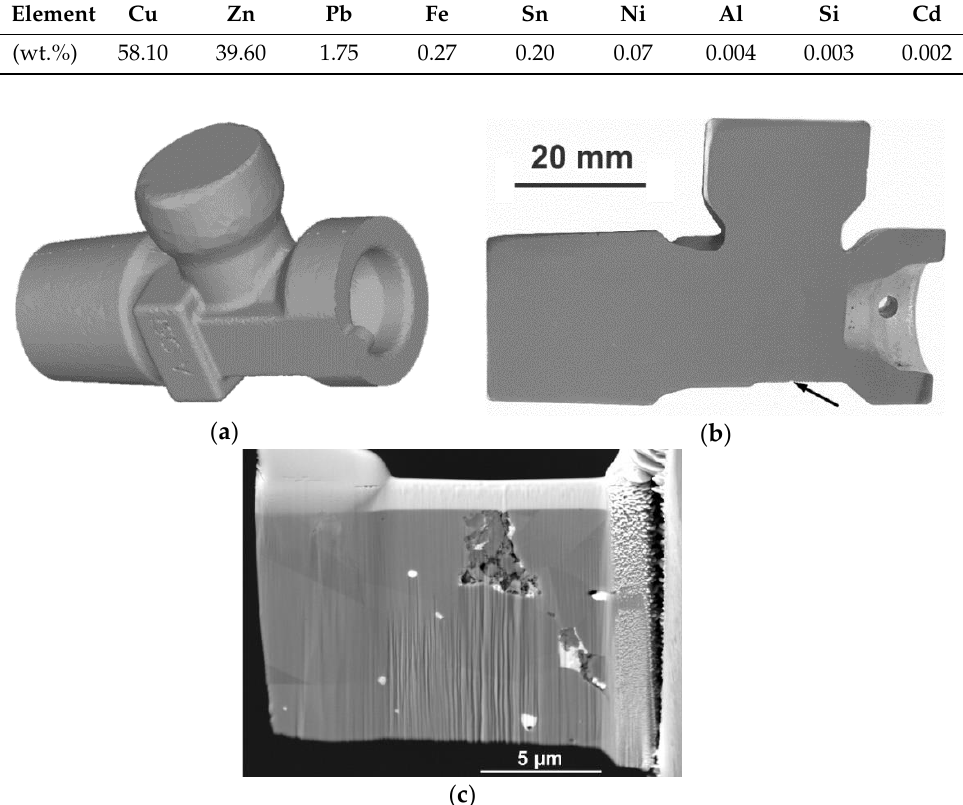
Figure 1. Numerical model of the investigated brass fitting ( a ); real cut through the brass fitting, with the location of cracking marked ( b ); lamella of the cracked region (before final milling), acquired using FIB ( c ).